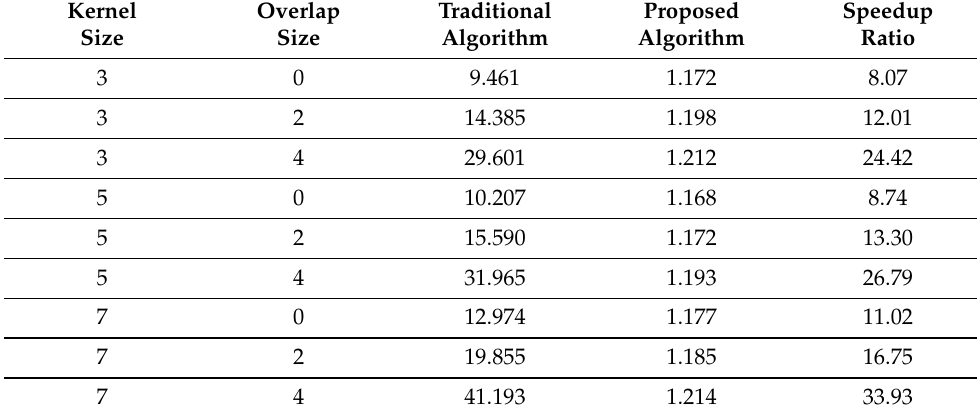
Table 3. ORL time (milliseconds) with different parameters for the proposed and traditional algorithms.